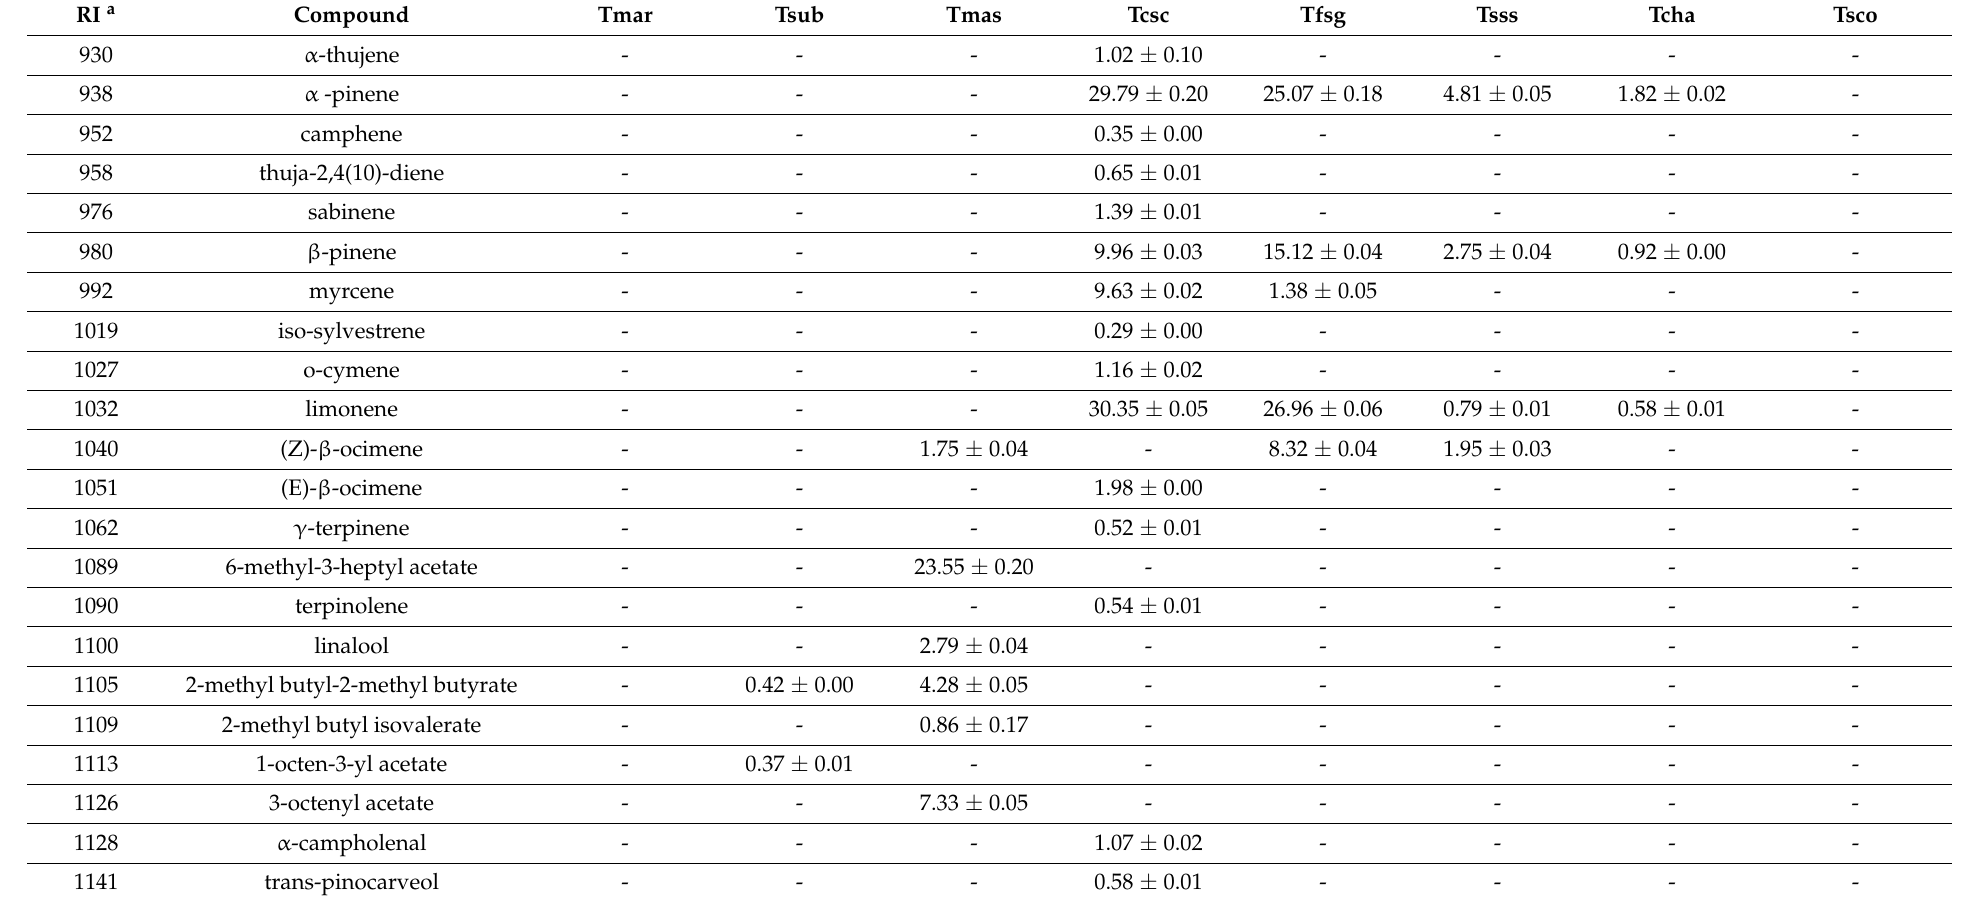
Table 1. List of the components identified in essential oils obtained from eight Sardinian Teucrium taxa selected in this study. For each compound, the relative quantitative amount (area %), expressed as the mean of three analytical repetitions ± SD, is reported. Tmar ( T. marum ), Tsub ( T. subspinosum ), Tmas ( T. massiliense ), Tcsc ( T. capitatum subsp. capitatum ), Tfsg ( T. flavum subsp. glaucum ), Tsss ( T. scordium subsp. scordioides ), Tcha ( T. chamaedrys subsp. chamaedrys ), and Tsco ( T . scorodonia